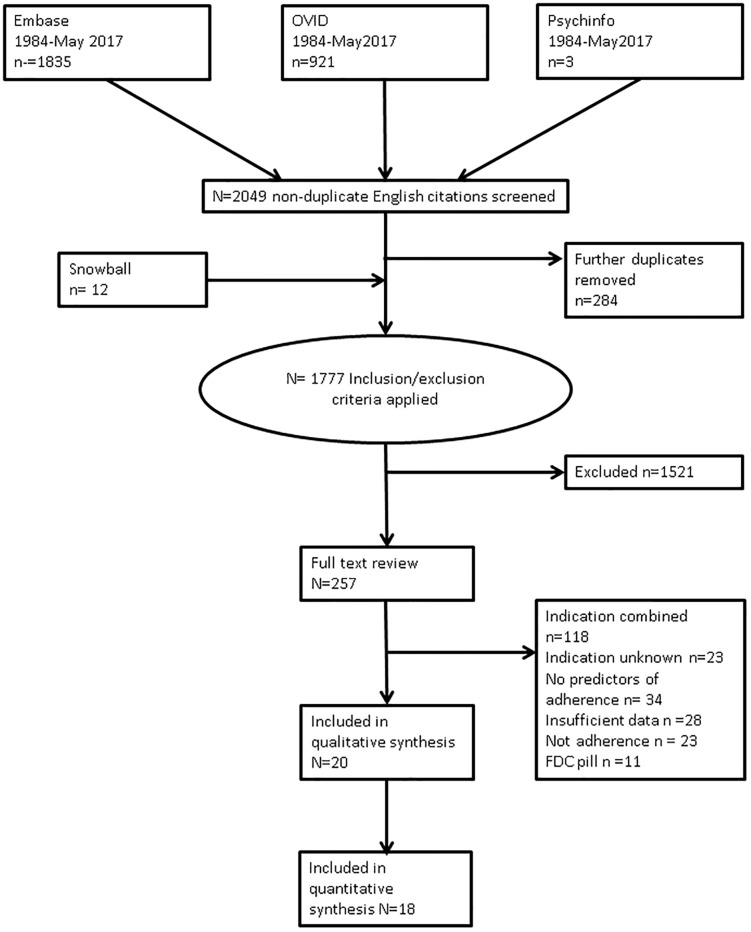
PRISMA flow diagram of article selection process.